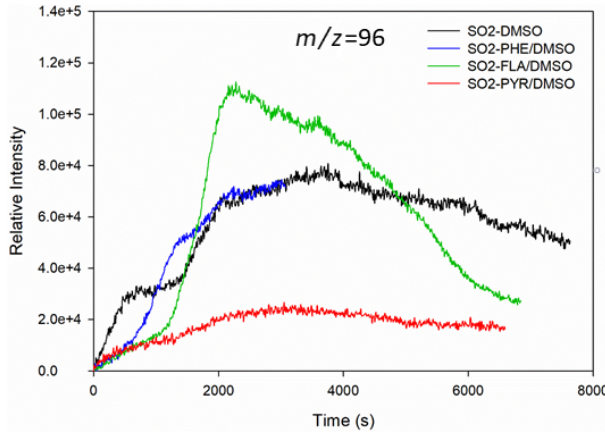
Figure 2. Formation profiles of m/z = 96 (methanesulfonic acid, MSA) upon light-induced heterogeneous reactions of SO 2 with DMSO and